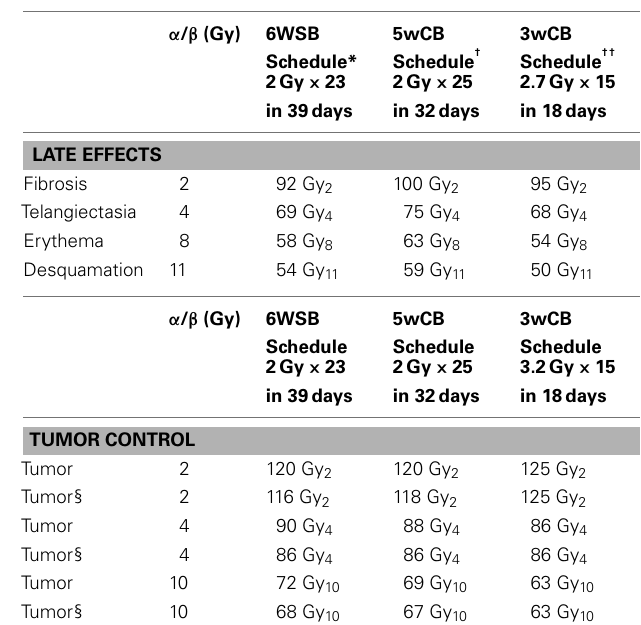
Table 1 | Biologically equivalent doses for late effects and tumor